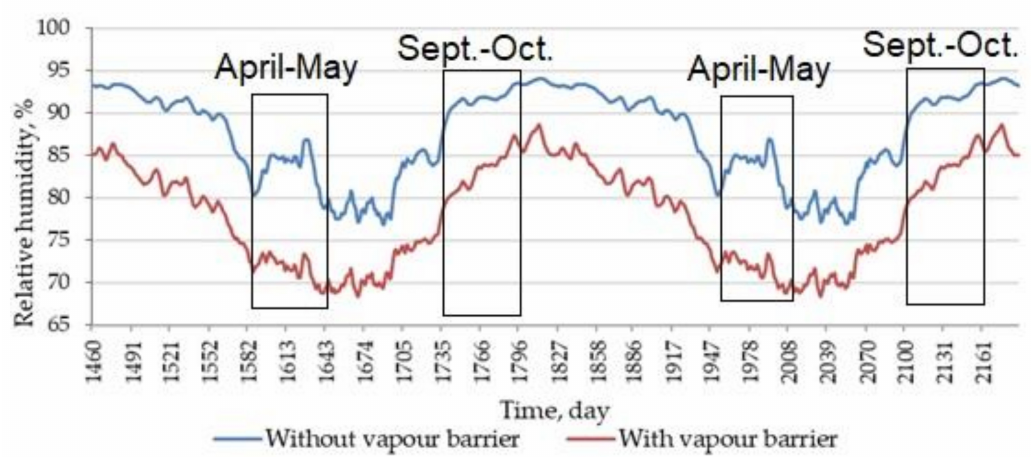
Figure 7. Relative humidity values between the insulation and the original wall modeled with